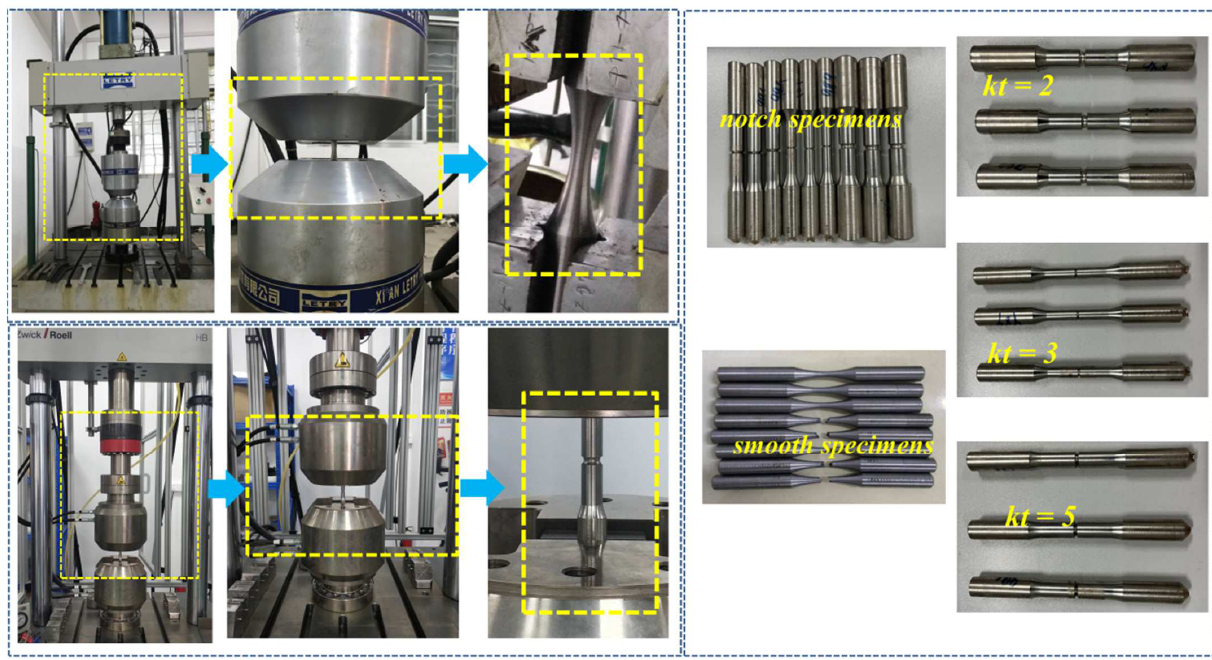
Figure 12. Illustration of the specimen clamping mechanical testing system.